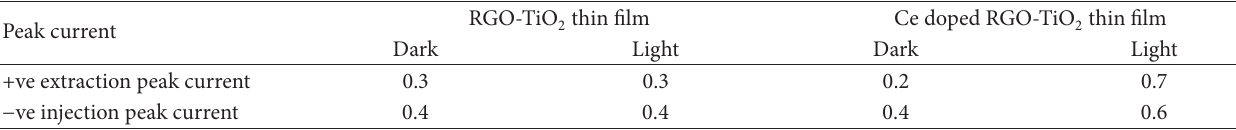
and Ce doped RGO-TiO 2